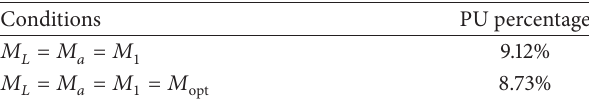
Table 2: The conditional probability of Experiment 1.